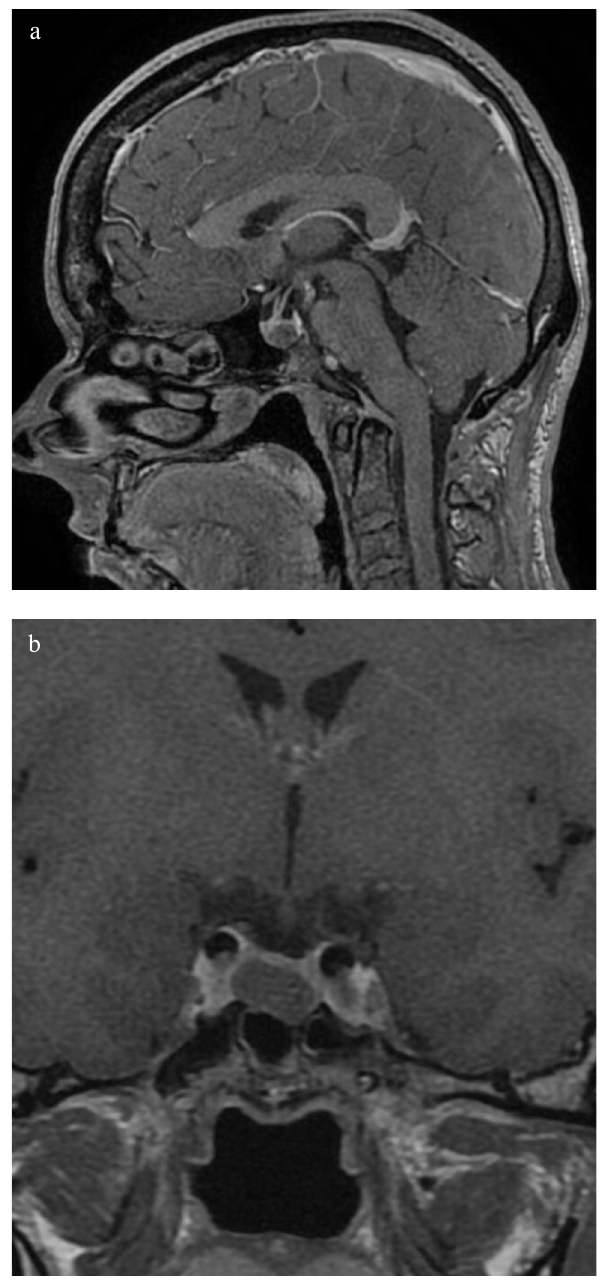
Fig. 3a, 3b. Contrast-enhanced MRI - T1WI. Sagittal section (a), coronal section (b) showing a non-enhanced pituitary mass 14 × 10 × 9 mm in size. The optic chiasm was not affected by the